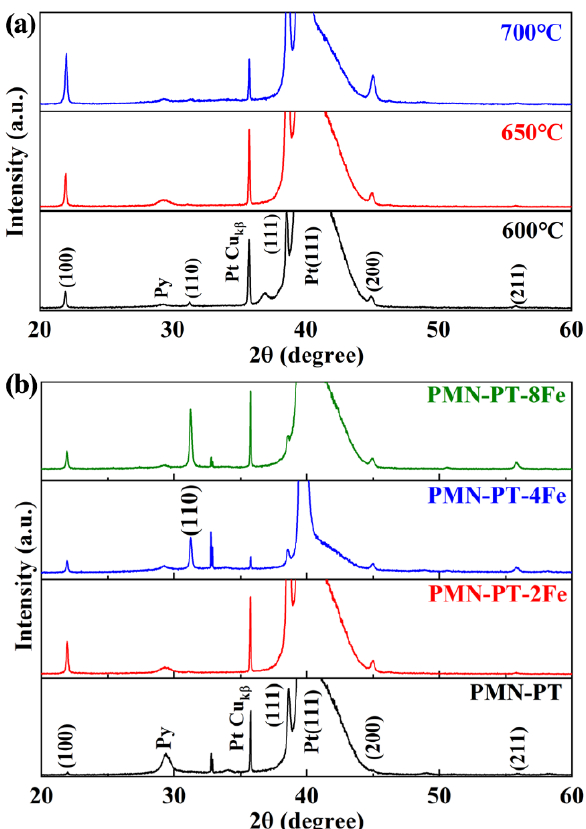
Figure 1. ( a ) XRD patterns of PMN-PT-2Fe thin films annealed at different temperatures, ( b ) XRD patterns of PMN-PT-xFe thin films annealed at 650 °C with different doping concentrations of Fe element. Note that the peaks at 21.95°, 44.98°, 38.65°, 55.81° correspond the (100), (200), (111) and (211) diffraction peaks of PMN-PT thin films, respectively. The 29.39° peak corresponds to the diffraction peak of pyrochlore structure.